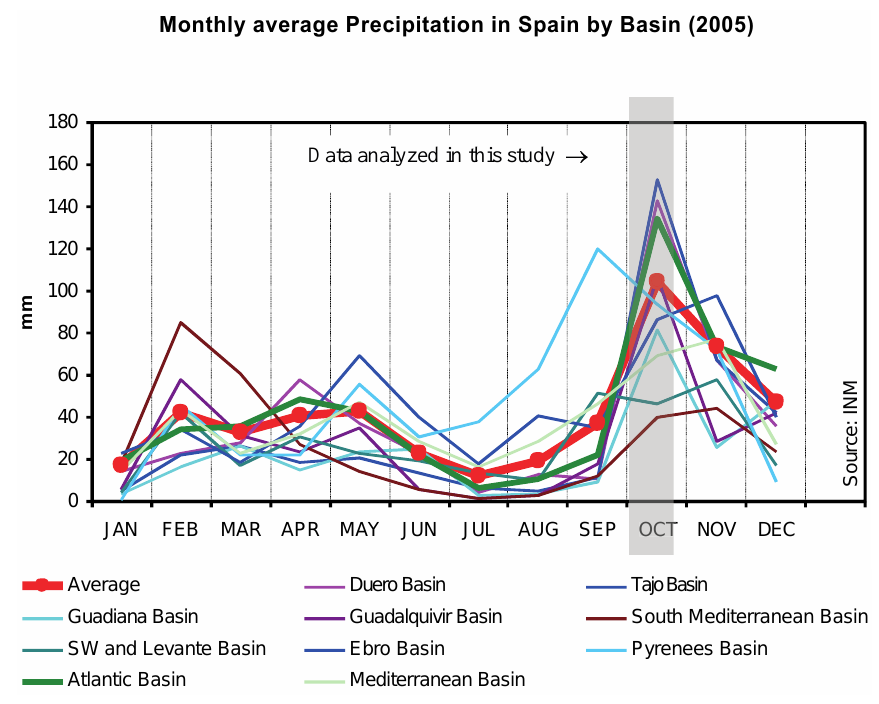
Figure 1. Rain gauge-derived monthly average precipitation in Spain during 2005 at basin level, indicating the data used for the present study. Data from the Spanish Meteorology Agency (AEMET) (formerly National Institute of Meteorology, INM).